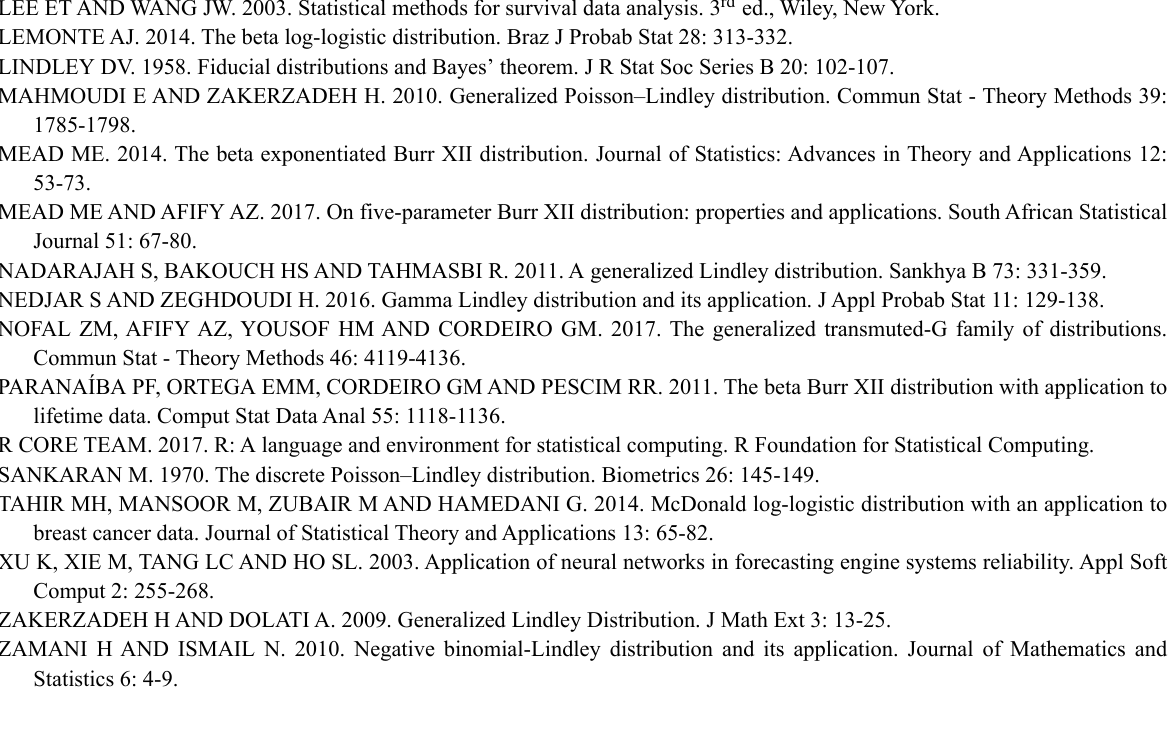
Figure S7 - PP-plots of the GOLiLL and GOLiLx distributions and other competitive distributions. Figure S8 - PP-plots of the GOLiBXII distribution and other competitive distributions.